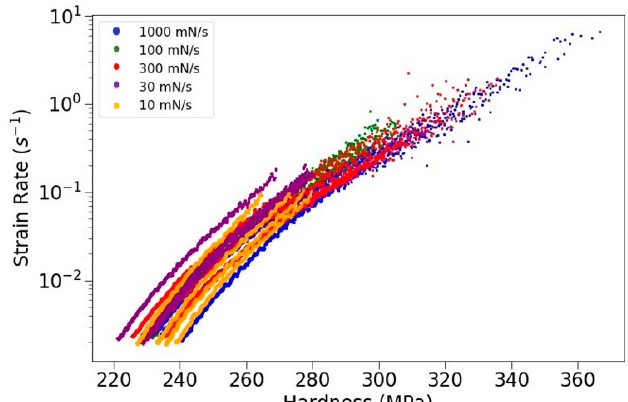
Figure 7. Plot of hardness vs. strain rate, derived from displacement data, for all experiments with a peak load of 100 mN. Each color corresponds to a different loading rate. No systematic differences are observed in the data, indicating that loading rate does not influence creep behavior during the hold at constant load.